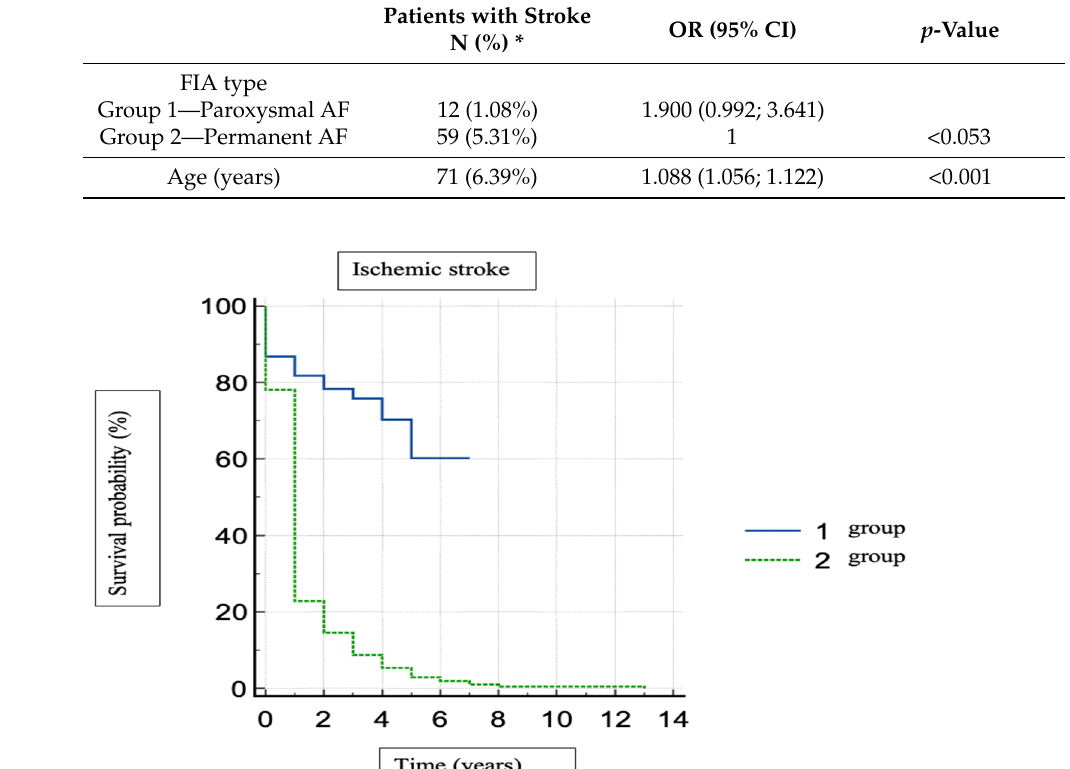
Table 9. Comparing patients with paroxysmal AF and permanent AF in the prevention of overall neuropsychiatric complications, stroke, dementia, and Parkinson’s disease undergoing treatment with and without oral anticoagulants, (using the Chi-square test).